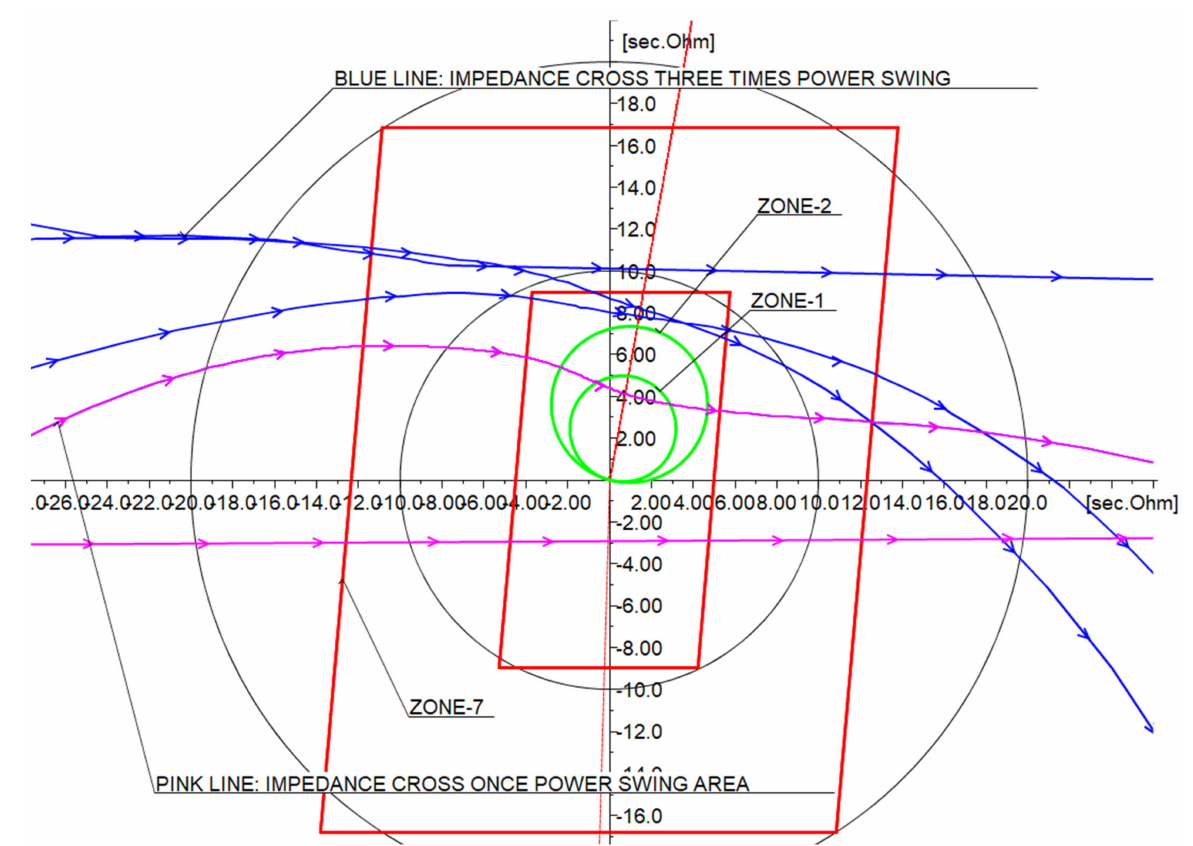
Figure 27. Results of the OOS relay impedance crosses in the one, two- and three-times power swing area: Proposed settings .